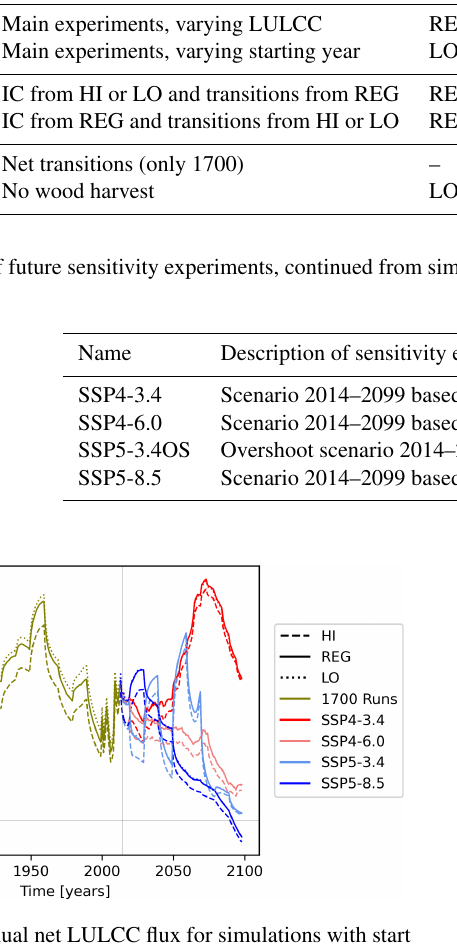
Figure 1. Global annual net LULCC flux for simulations with start year 1700 and HI, REG and LO LULCC scenarios of the LUH2 dataset (LO1700, REG1700 and HI1700). From 2014 onwards, each of the three historical simulations is continued with four dif- ferent scenarios of future